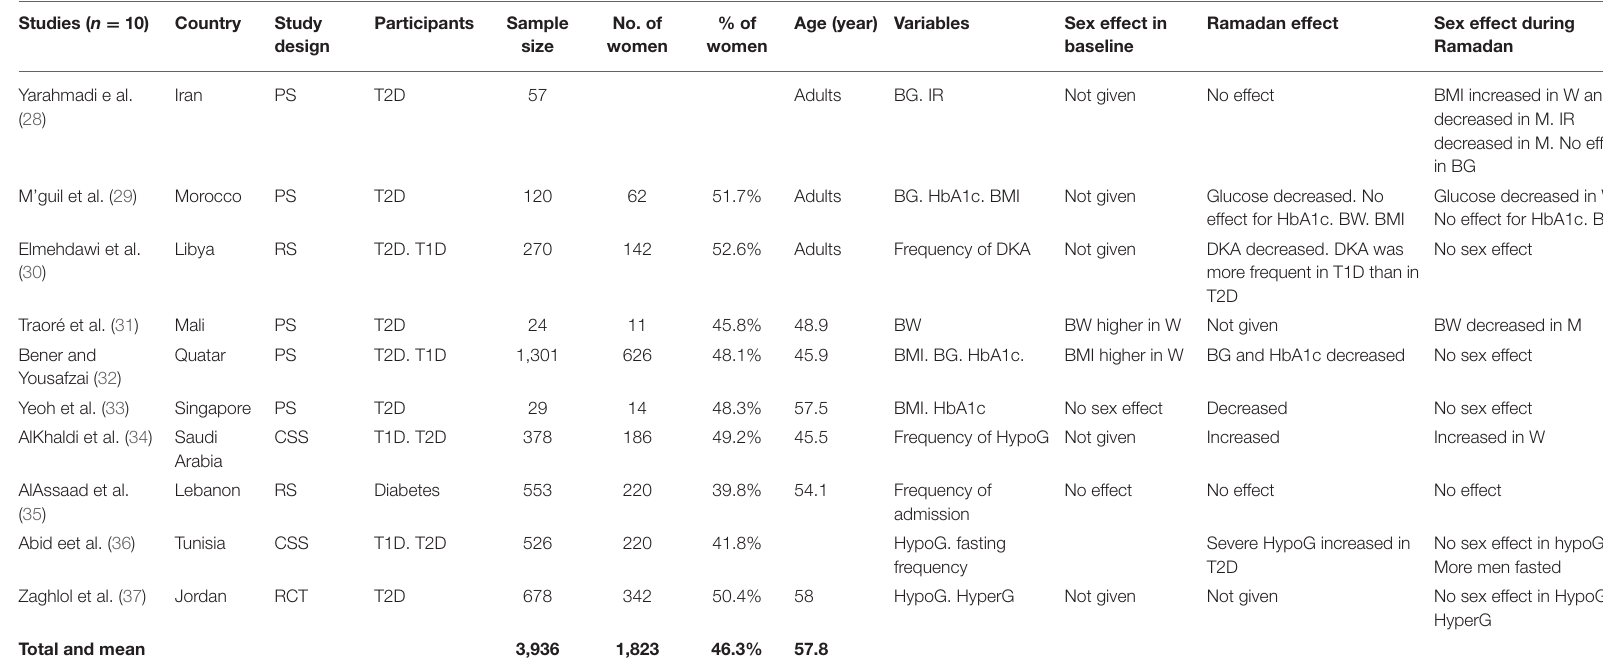
TABLE 3 | Sex differences in outcomes related to diabetes in patients before and during Ramadan